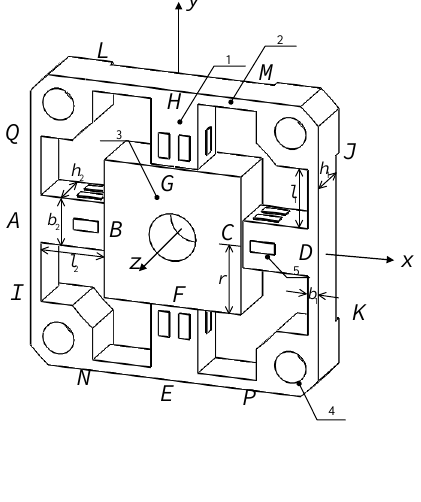
Figure 2. Geometric characteristics of the elastic body. ( 1 ) Cross elastic beams; ( 2 ) Compliant beams; ( 3 ) Square convex; ( 4 ) Location holes; ( 5 ) Strain